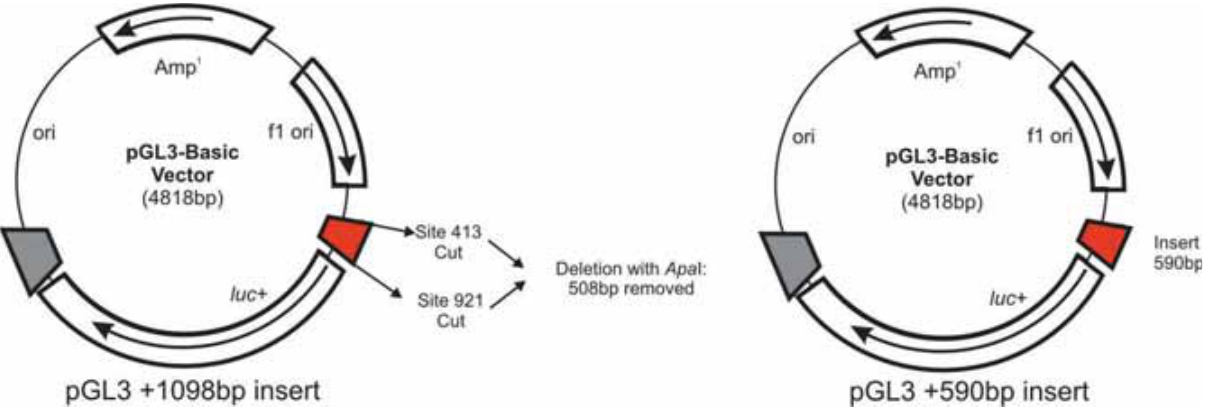
Figure 1- Construct Pgl3PAX9ApaI was digested with ApaI and re-ligated resulting in a plasmid containing the 691bp (by L. L.